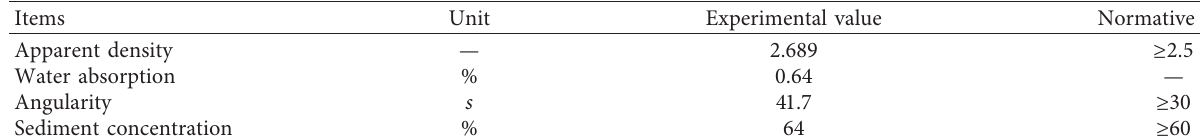
Table 3: Properties of aggregates.